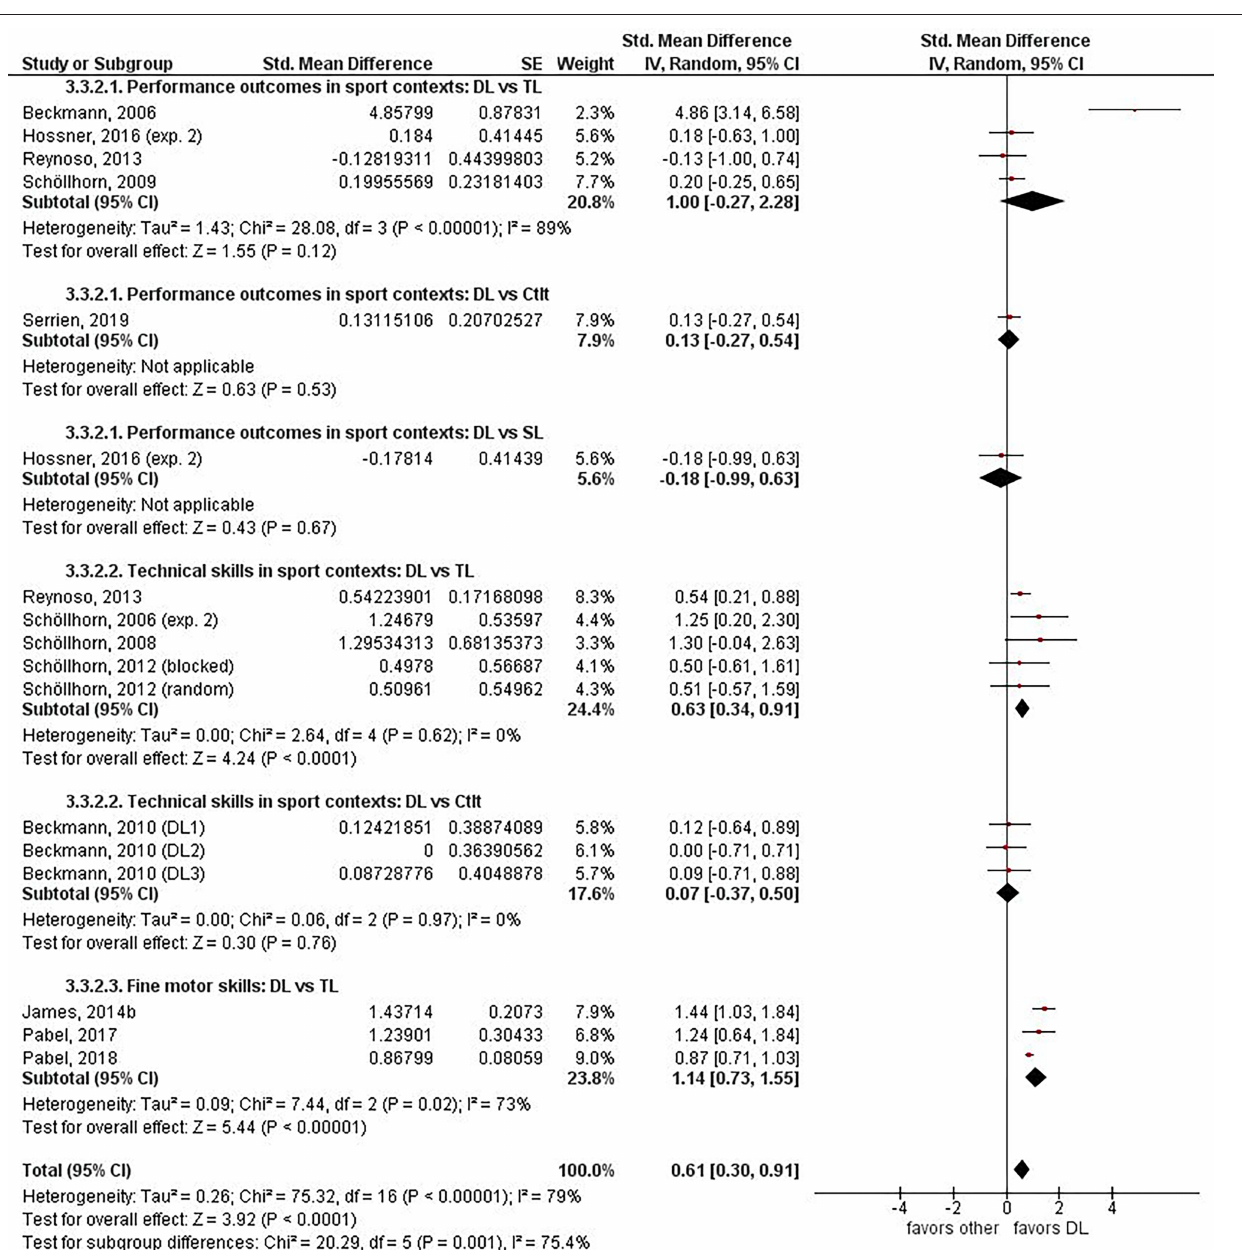
FIGURE 3 | Learning phase (retention – pre). Forest plot for the effects of differential learning vs. other methods grouped by category of movement task. DL, differential learning; TL, traditional learning; CtIt, contextual interference; SL, structural